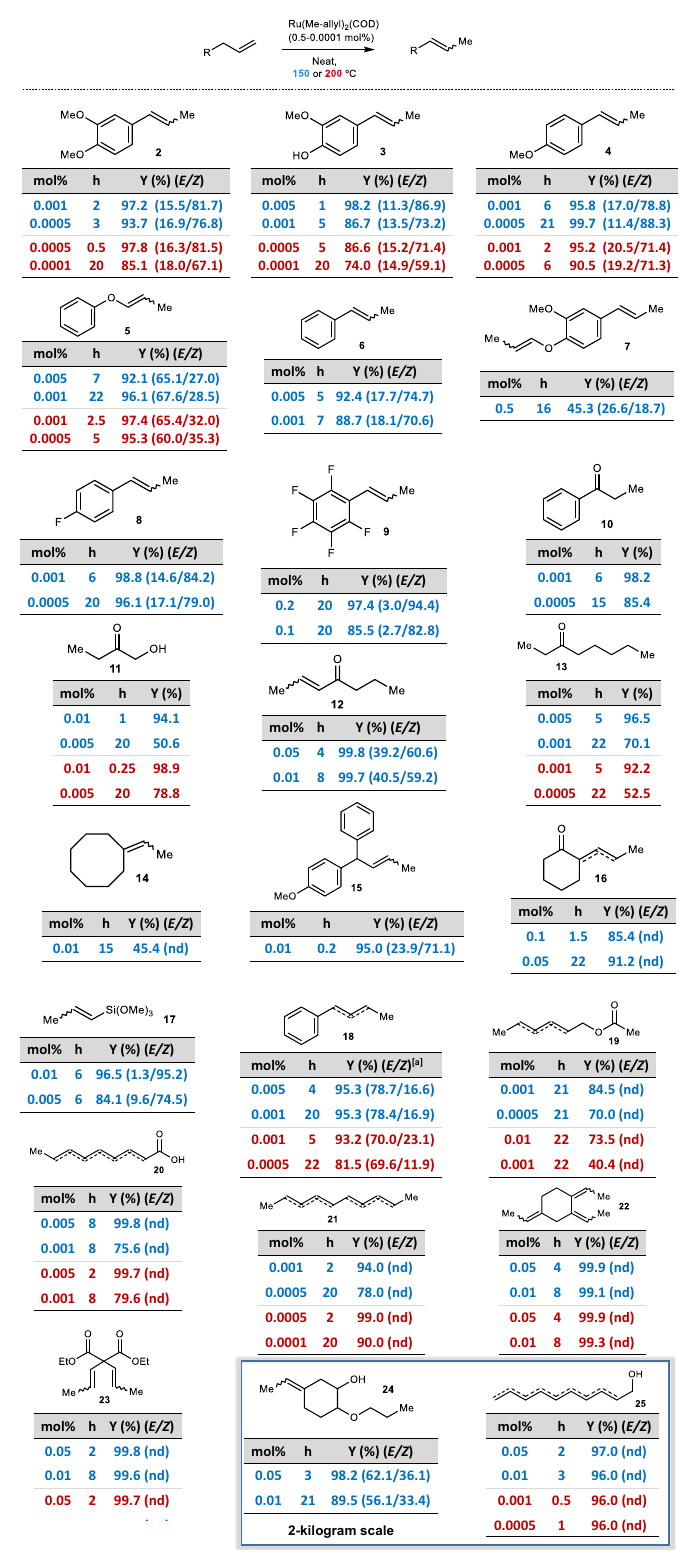
Fig. 3 Scope of products from neat isomerization reactions with catalytic Ru(methylallyl) 2 (COD). The reactions are carried out at 5 gram scale, and also at 2 kg scale for the industrial fragrance products. The structure of the internal alkene products together with different reaction conditions are shown. Isolated yields, “ nd ” stands for not determined. [a] E/Z refers to 2 – alkene/3 –